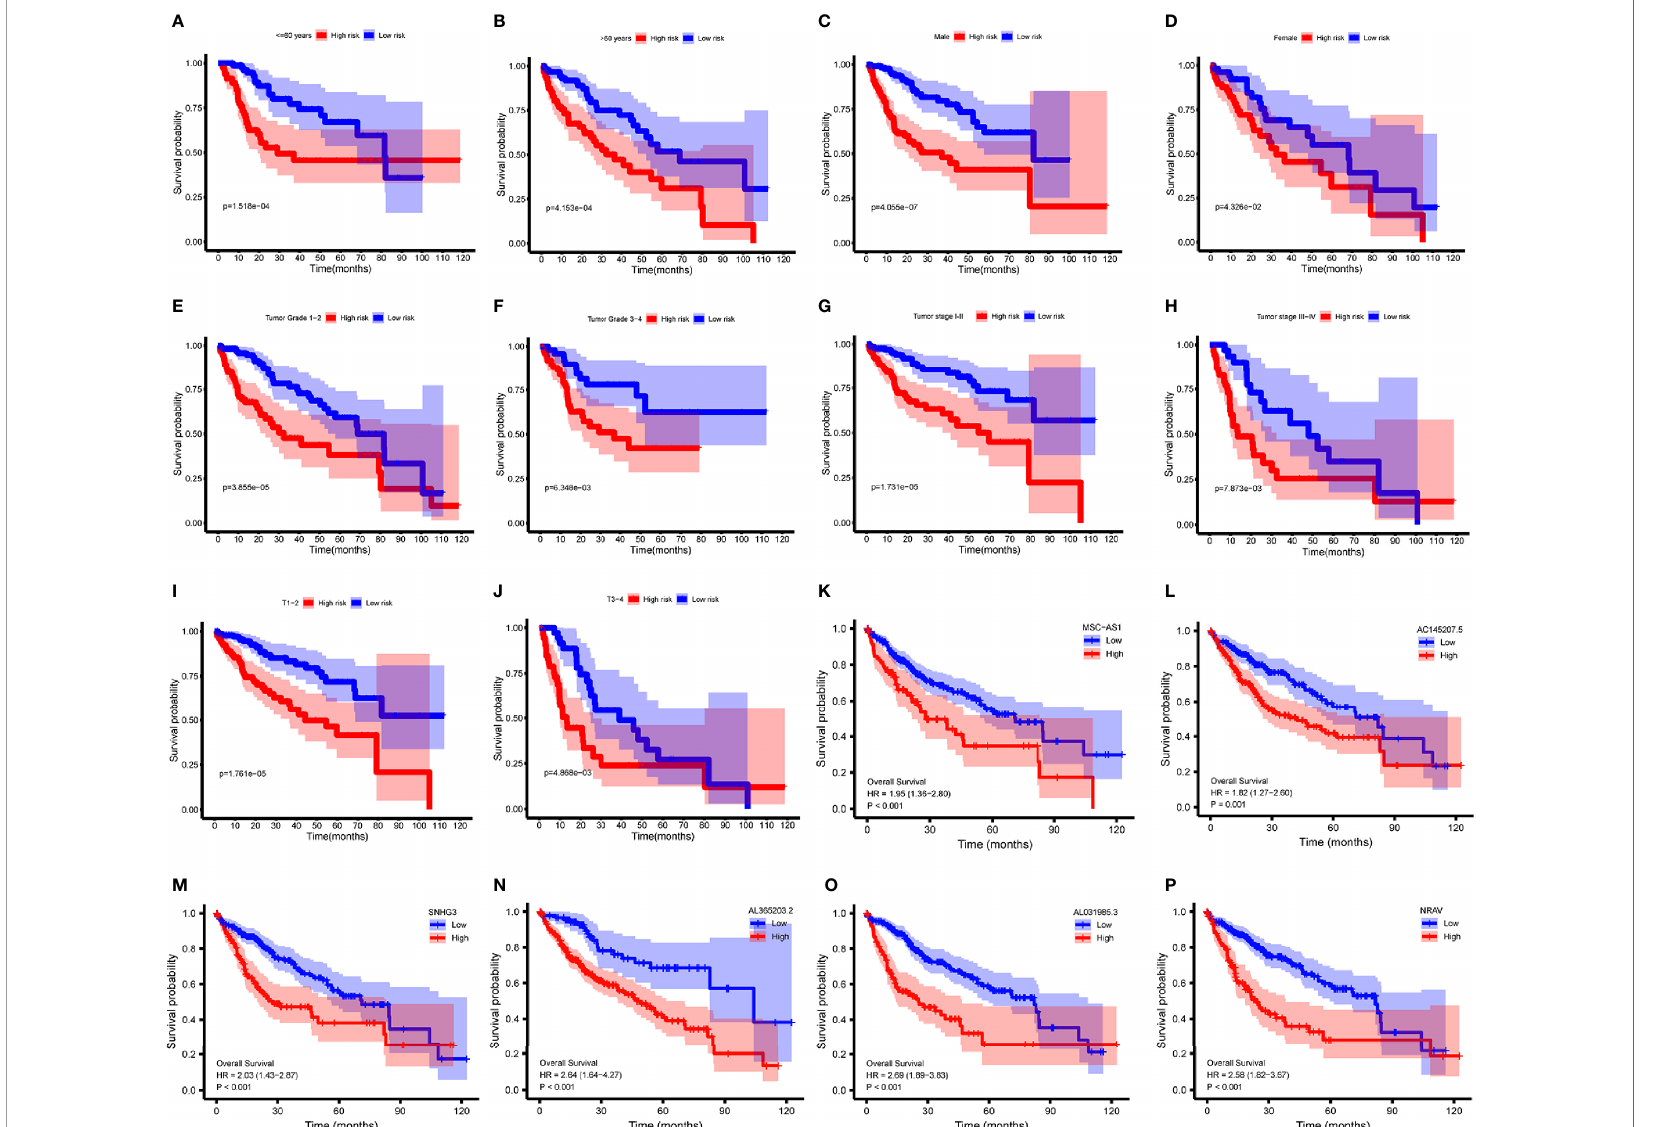
FIGURE 4 | Survival analysis. (A – J) Kaplan-Meier survival curves showed that the immune − related lncRNAs signature could predict survival in each stratum of age, gender, stage and T-stage. (K – P) Kaplan-Meier survival curves showed that the high lncRNA expressions correlated with worse